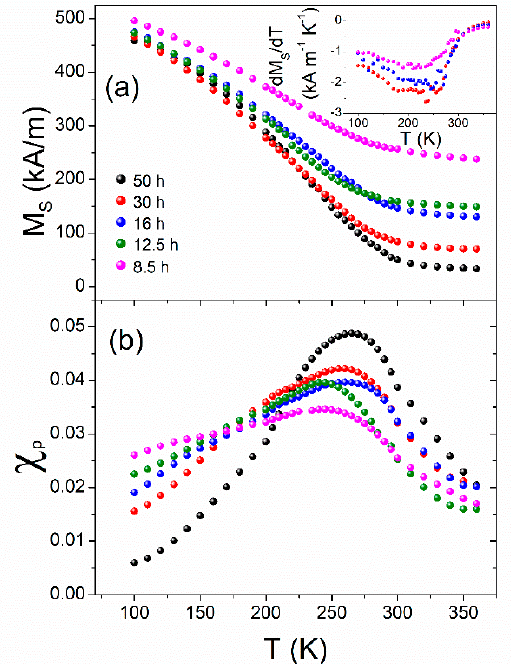
Figure 7. ( a ) Saturation magnetization and ( b ) paramagnetic susceptibility curves from the law of approach to saturation after different times of milling.